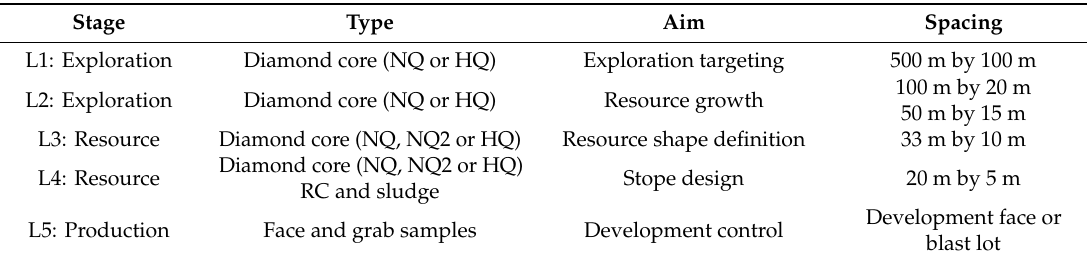
Table 10. Lihir gold limited (LGL) evaluation stages.